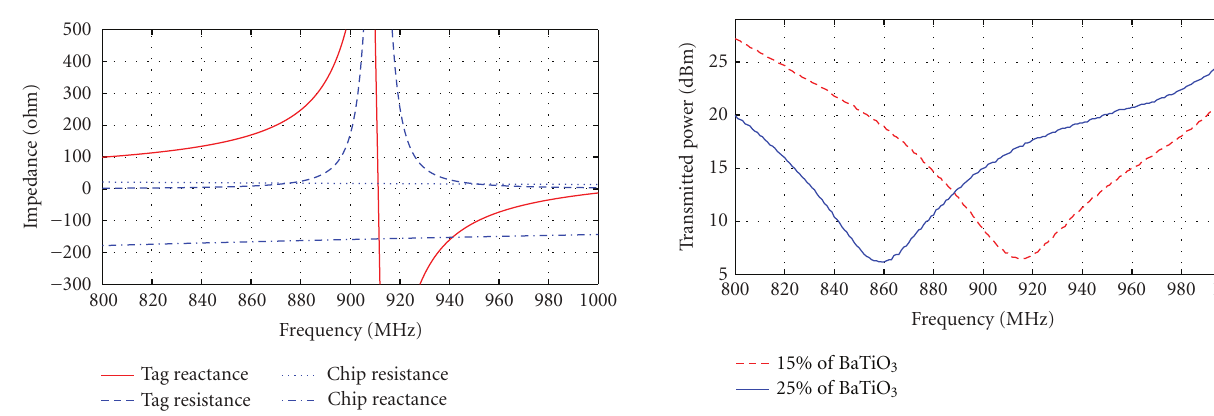
Figure 9: Simulated chip and antenna impedance of the UHF RFID tag on top of a 25% ceramic-polymer composite.